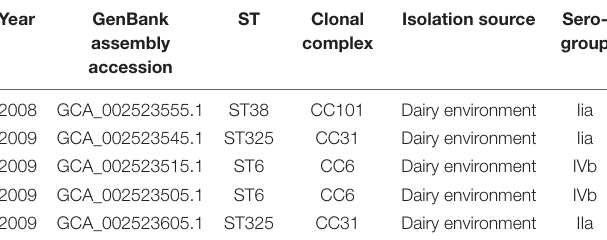
TABLE 1 | L. monocytogenes strains used in this